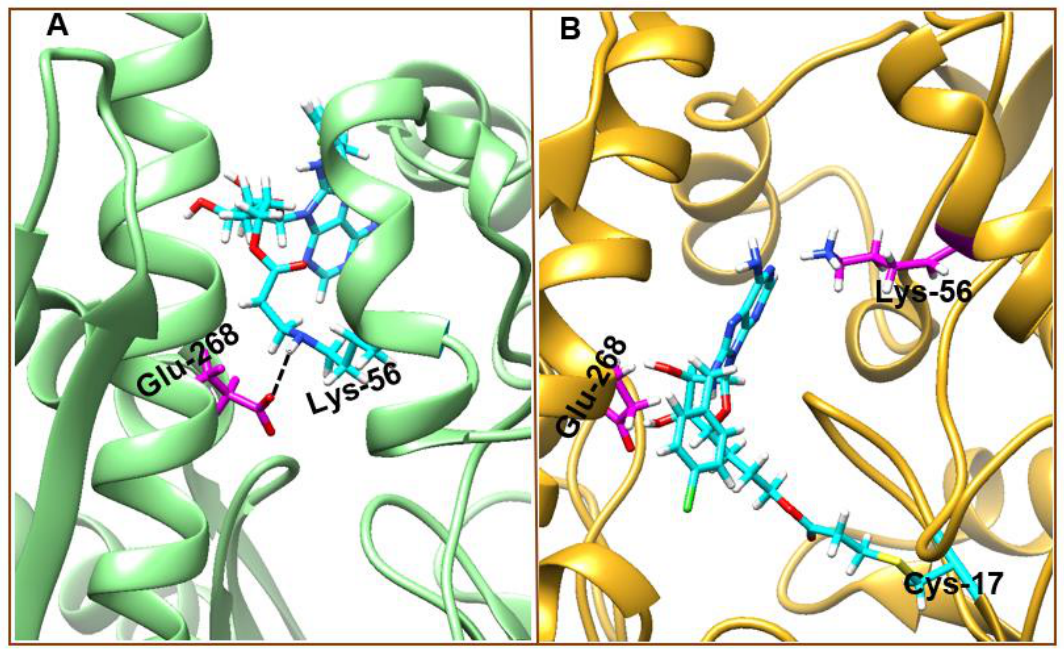
Figure 10. s . Lys-56-8- N -benzyladenosine ( A ) and Cys-17-8- N -benzyladenosine ( B ) coupled HSP72- NBD irreversible interaction mechanism. Crucial salt-bridge between Glu-268 and Lys-56 residues were missing in the Cys-17 coupled